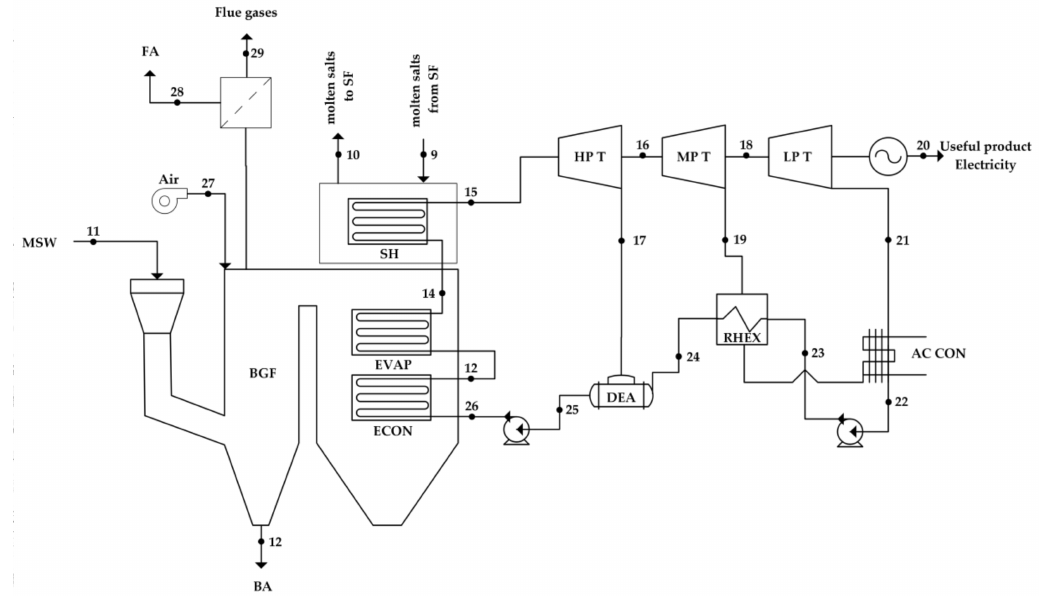
Figure 2. Structure of WtE Rankine cycle: MSW—municipal solid wastes, BGF—boiler furnace, ECON—economizer, EVAP—evaporator, SH—superheater, HP T—high pressure turbine, MP T—Medium pressure turbine, LP T—low pressure turbine, AC CON—air-cooled condenser, RHEX, regenerative heat exchanger, DEA—deaerator, FA—fly ashes, BA—bottom